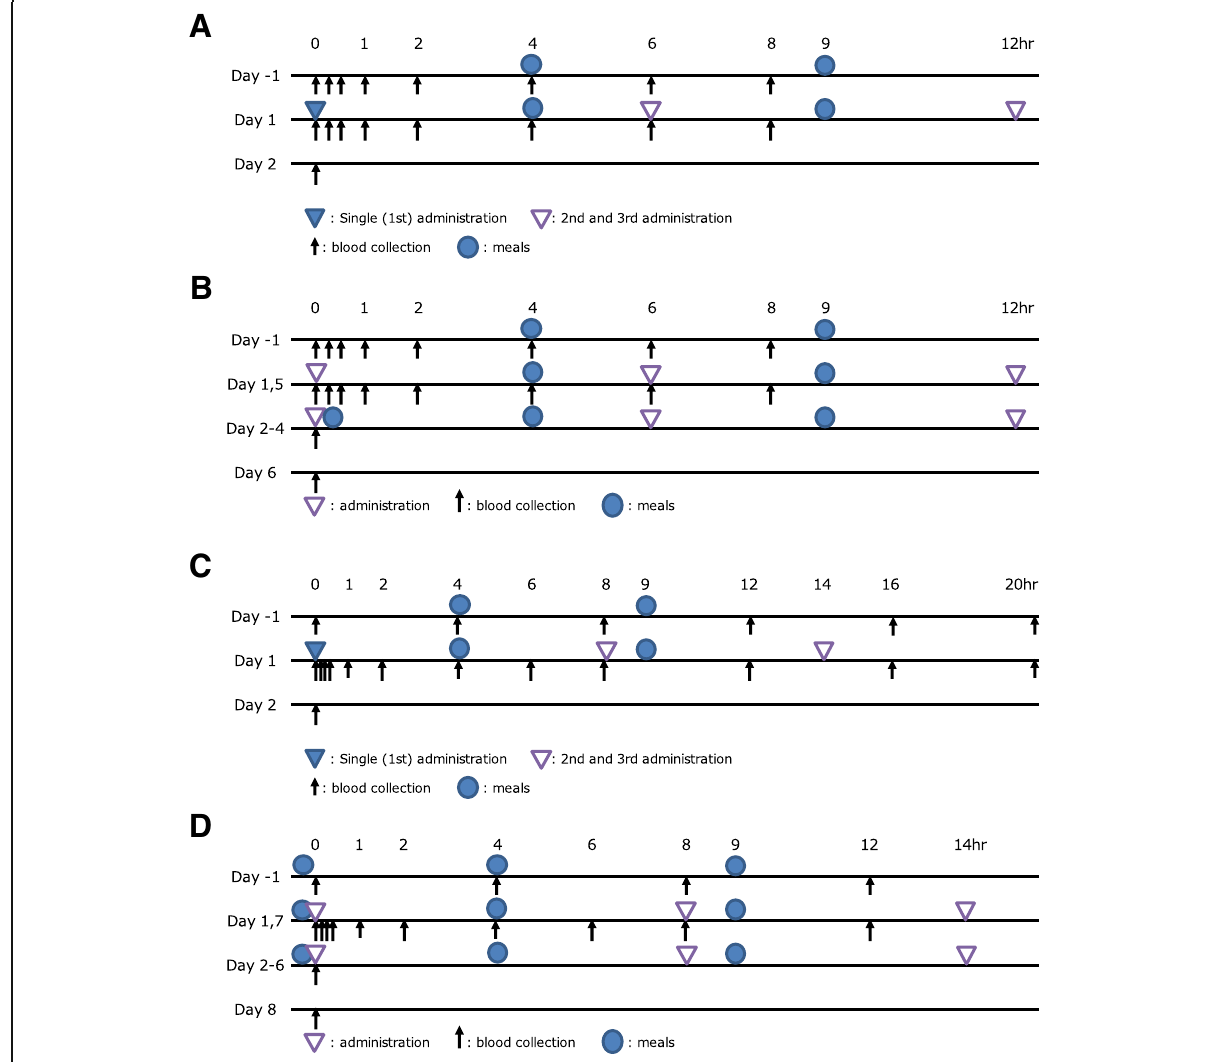
Fig. 1 Timing of administration of test drugs, blood sampling, and meals in Trial-1 and Trial-2. a . Single administration and three-times-per-day administration for Trial-1. b . Three times per day for 5-day administration for Trial-1. c . Single administration and three-times-per-day administration for Trial-2. d . Three times per day for 7-day administration for Trial-2. Triangle indicates the timing of administration. Arrows indicate the timing of blood collection. Stars indicate meals. Since aceneuramic acid also exists intravitally, we measured it during the day before the start of administration as